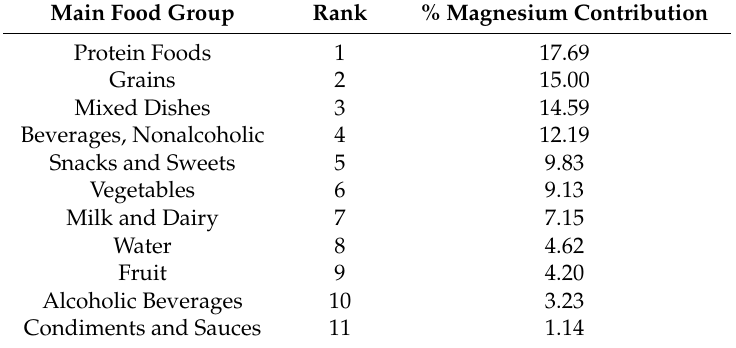
Table 9. Food sources of magnesium contribution in the total U.S. diet, adults ≥ 51 years old ( n = 4522; gender combined; daily intake data; NHANES 2011–2014; main food groups contributing <1.0% not reported data are Day 1 intakes).